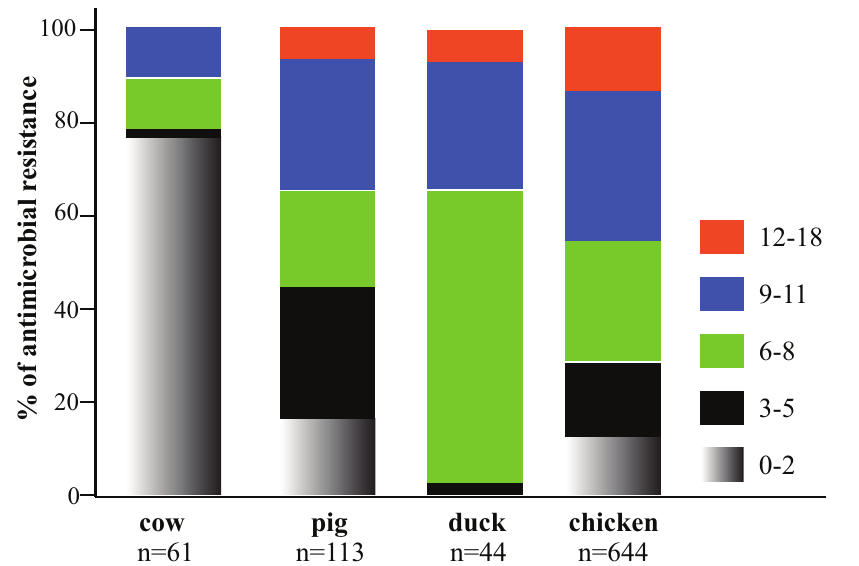
Fig 2. Antibacterial resistance patterns of Escherichia coli isolates. A. Percentagesof E . coli isolates from chickens, pigs, cows and ducks were resistant to 0–2, 3–5, 6–8, 9–11 and 12–18 antibacterial drugs, respectively. While 78.7% (48/61) of cow isolates showedresistance to 0–2 drugs, the pig isolates showed similar resistancesto 3–5 drug (27.4%, 31/113), 6–8 drugs (23.0%, 26/113), and 9–11 drugs (24.8%, 28/113). In ducks, most isolates were resistant to 6–8 drugs (61.4%, 27/44) and 9–11 drugs (31.8%, 14/44). The worst bacterial resistancewas seen in chickens, and 71.6% of the isolates were resistant to more than